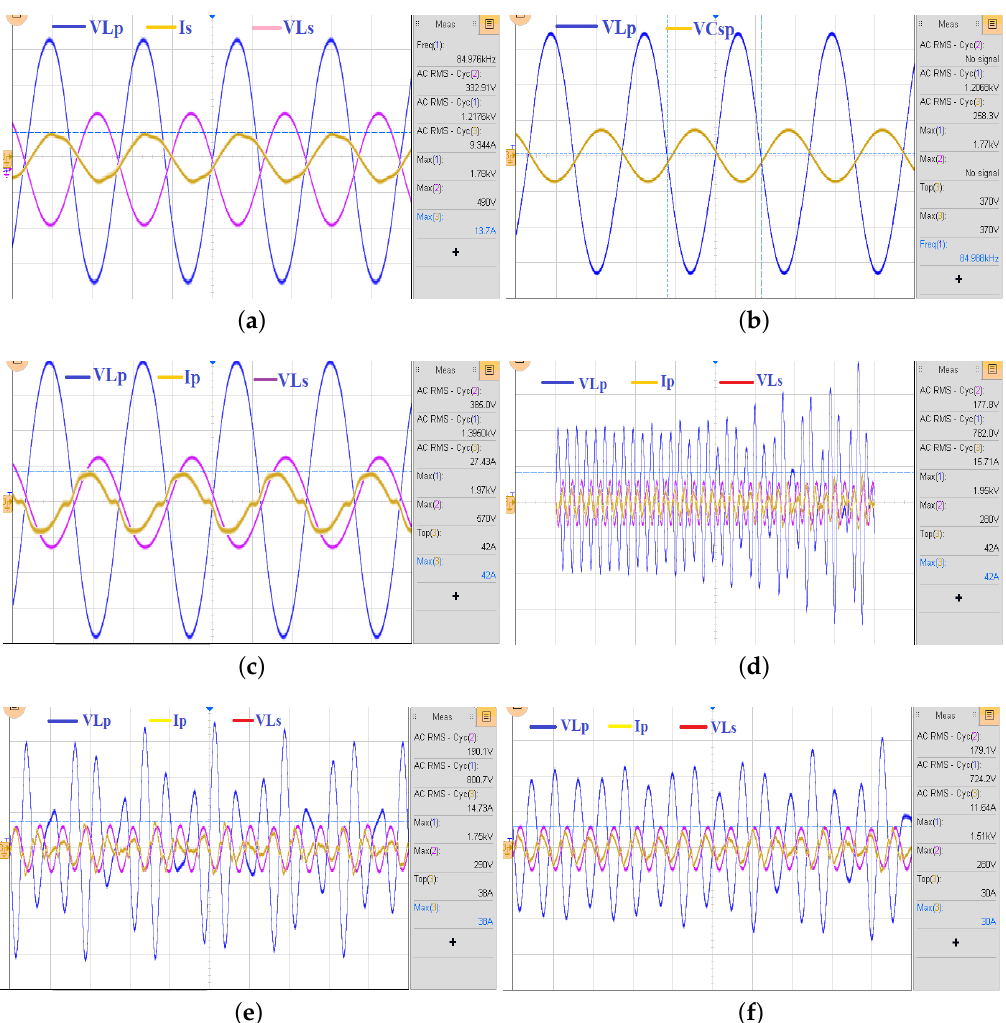
Figure 16. Experimental waveforms. ( a ) Voltage VL p , current I s , and voltage VL s . ( b ) Voltage VL p and VC sp . ( c ) Steady state voltage and current waveform. ( d ) AC transients, due to horizontal misalignment. ( e ) AC transients, due to horizontal and vertical misalignment. ( f ) AC transients, due to minor perturbations ofthe coil.